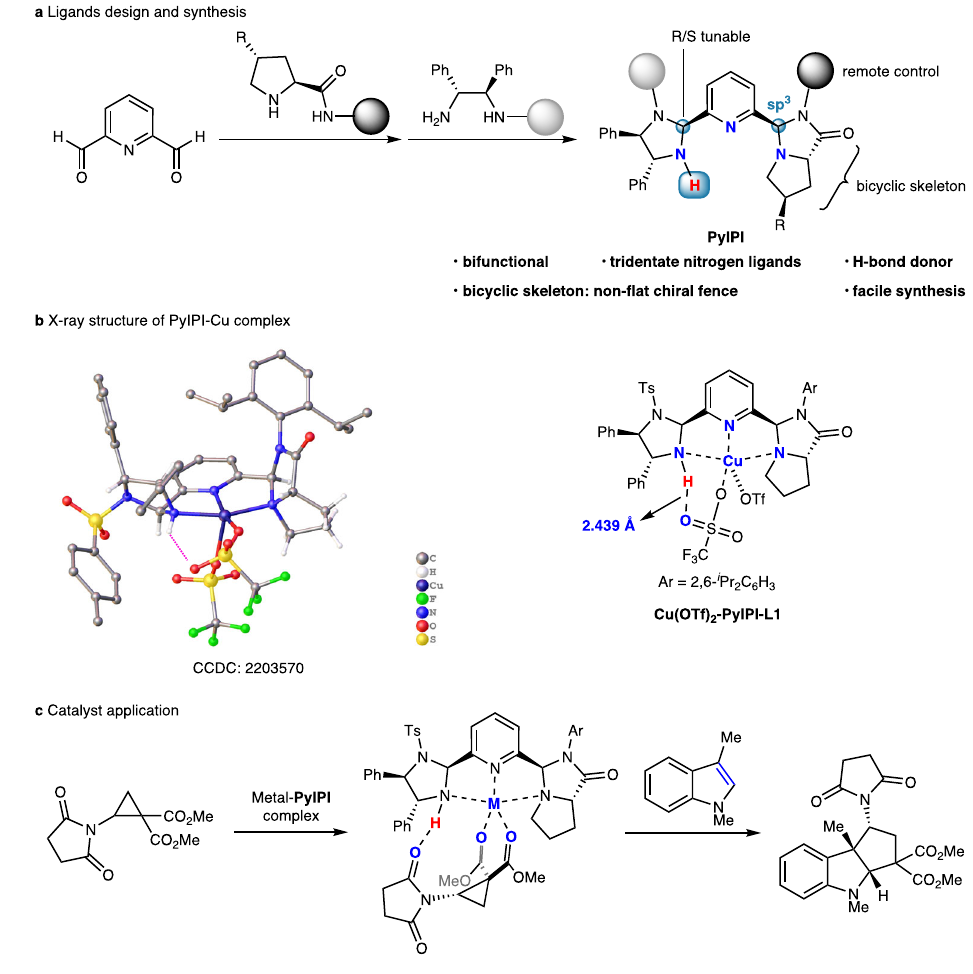
Fig. 2 | Design, synthesis, and application of PyIPI ligands. a Design and synthesis of PyIPI ligands. b X-ray structure of Cu(OTf) 2 -PyIPI L1 complex. c Metal-PyIPI complex catalyzed asymmetric dearomative [3+2] annulation of